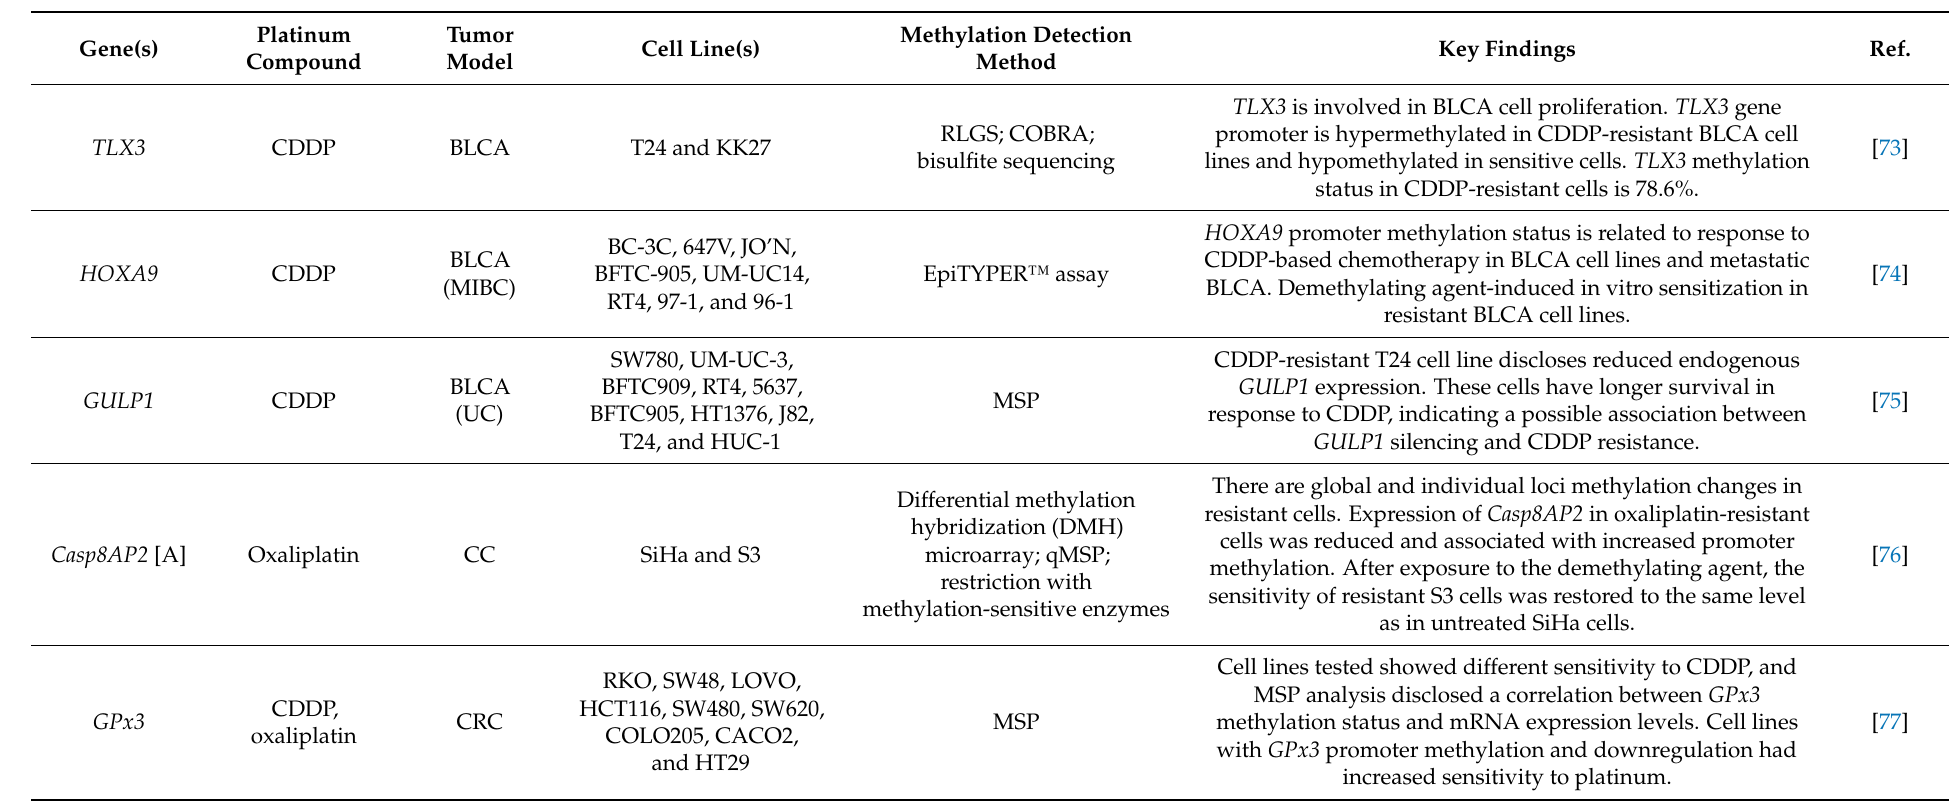
Table 1. Promising DNA methylation markers predictive of resistance to platinum-based chemotherapy (mechanistic studies with cell lines). Genes related with the three most common platinum drug resistance pathways are indicated as [T], genes encoding proteins’ transporters, related with cellular uptake of platinum drugs; [R], genes encoding proteins responsible for DNA damage repair; or [A], genes encoding proteins related with the induction of apoptotic cell